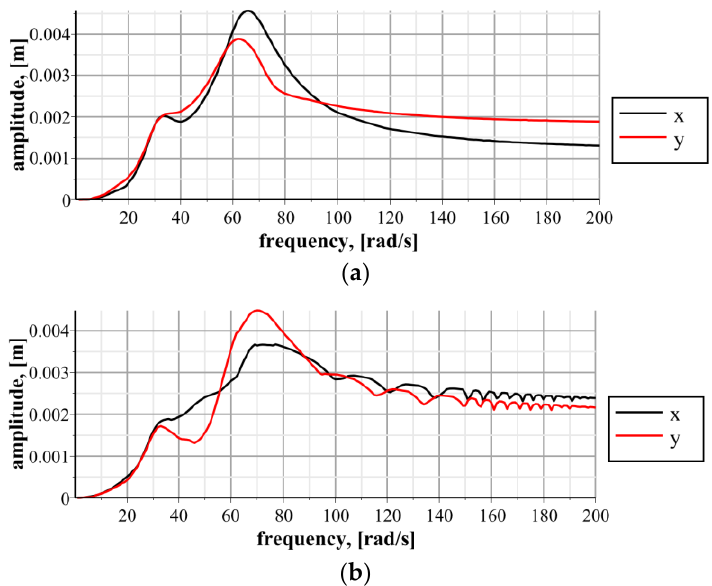
Figure 11. Amplitude–frequency characteristics of the vibratory system for under synchronization condition ω 2 = 2 ω 1 at the phase-shift angles of ( a ) ϕ = 0 ◦ and ( b ) ϕ = 180 ◦